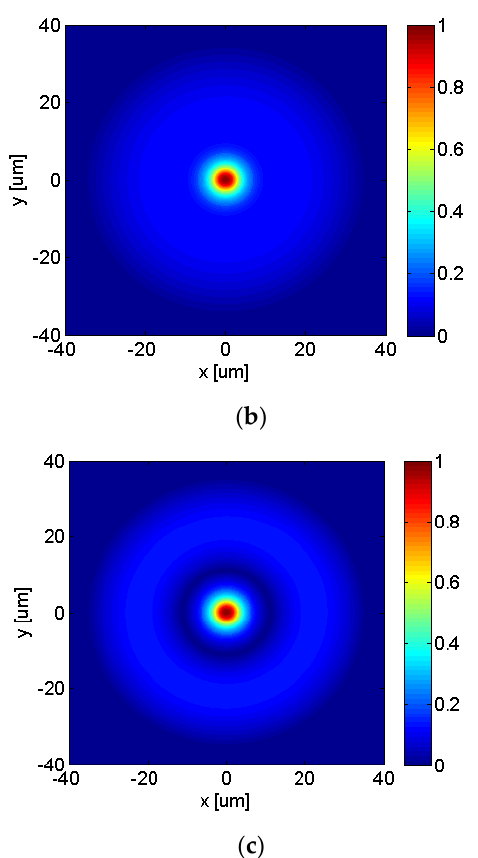
Figure 2. ( a ) ∆ β of the modes HE 11 and HE 12 during ρ tube variation at λ 0 = 1.55 μm . Inset outlines the effective refractive indexes near the phase-matching. ( b , c ) show the normalized modulus of the E-field for the modes HE 11 and HE 12 , respectively, at the phase matching condition.